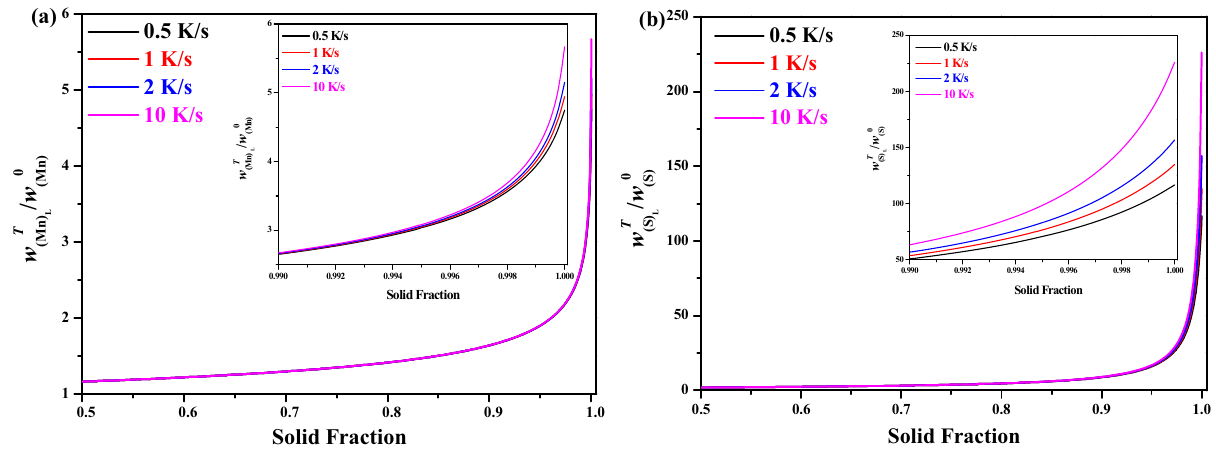
Figure 1: Segregation ratios of solute elements Mn and S at different cooling rates.